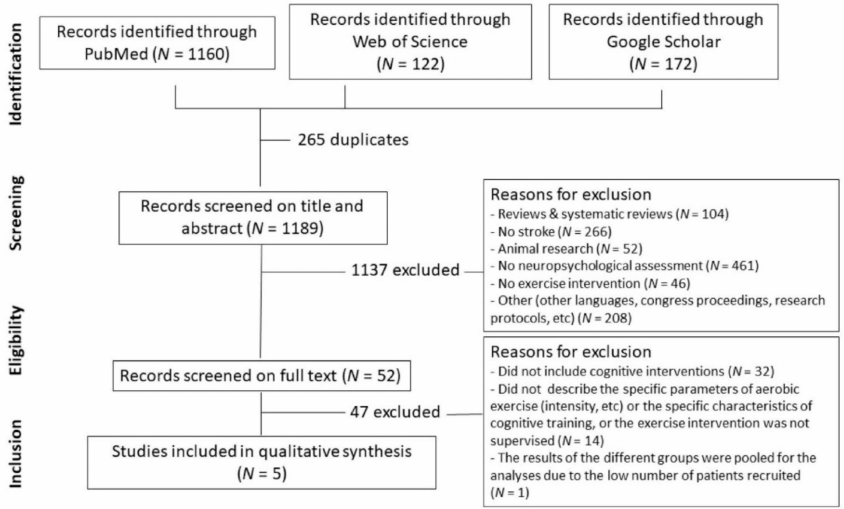
Figure 1. Flow diagram of literature search and selection of